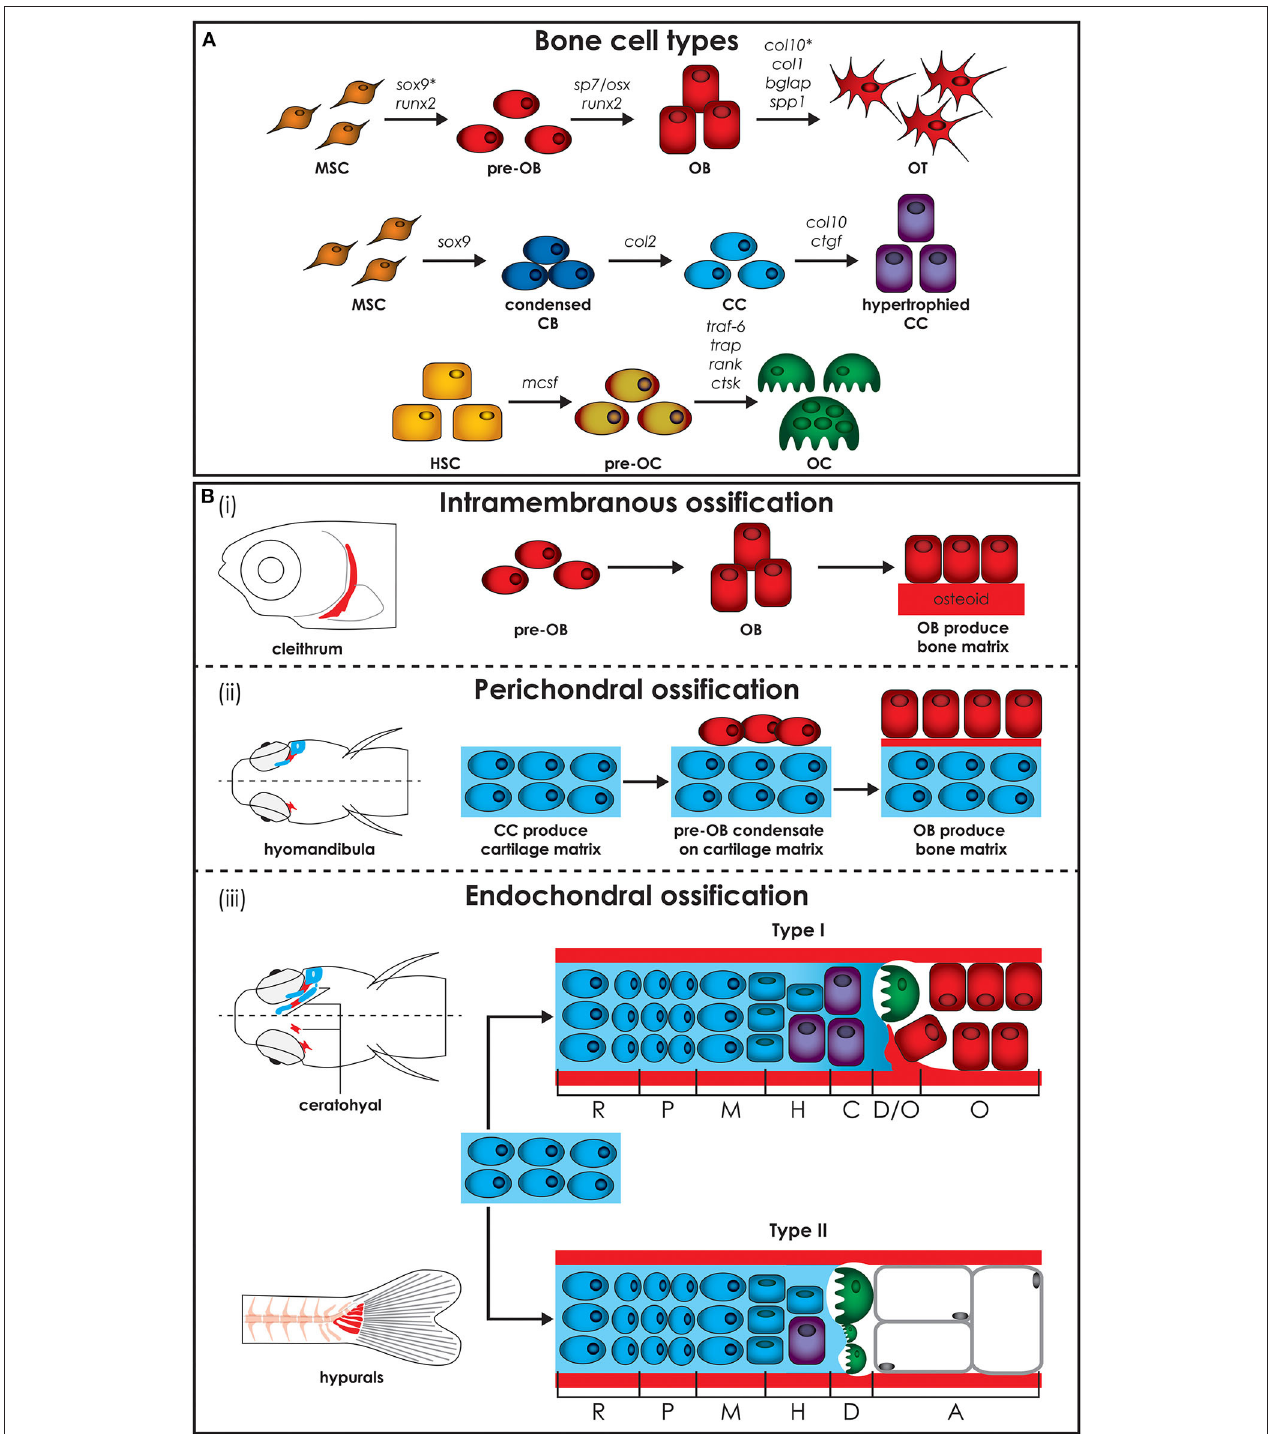
FIGURE 2 | Zebrafish bone cells and ossification types. (A) Bone is formed by osteoblasts and osteocytes, while cartilage is formed by chondroblasts and chondrocytes, and both bone and cartilage are degraded by osteoclasts. All bone cell types develop from progenitors similar to the mammalian counterpart and share similar gene expression profiles (genes are indicated above arrows). Note however that HSCs in zebrafish are not present in the bone marrow but in the head kidney. In addition, the genes for collagen X, encoded by col10 , and SRY-box transcription factor 9 (indicated by*), encoded by sox9 , are expressed during osteoblasts differentiation in zebrafish, but not in humans. (B) Three types of ossification are present in zebrafish: (i) intramembranous ossification, (ii) perichondral ossification,